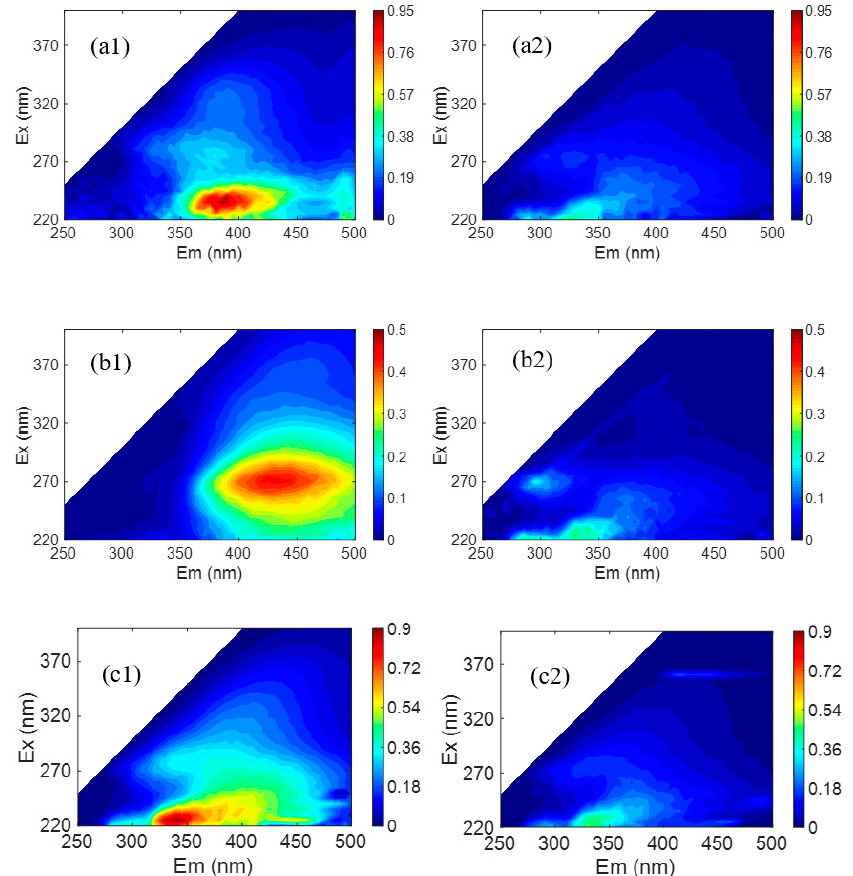
Figure 5. FEEM spectra of the feed water (on the left) and the permeate water (on the right) when LNF2 was used. ( a1 ) An activated carbon filter effluent collected from a local pilot plant and ( a2 ) the permeate; ( b1 ) the synthetic feed water containing fulvic acid and ( b2 ) the permeate; ( c1 ) the effluent of a high-rate settling tank at a surface water treatment plant in Shandong and ( c2 ) the permeate.